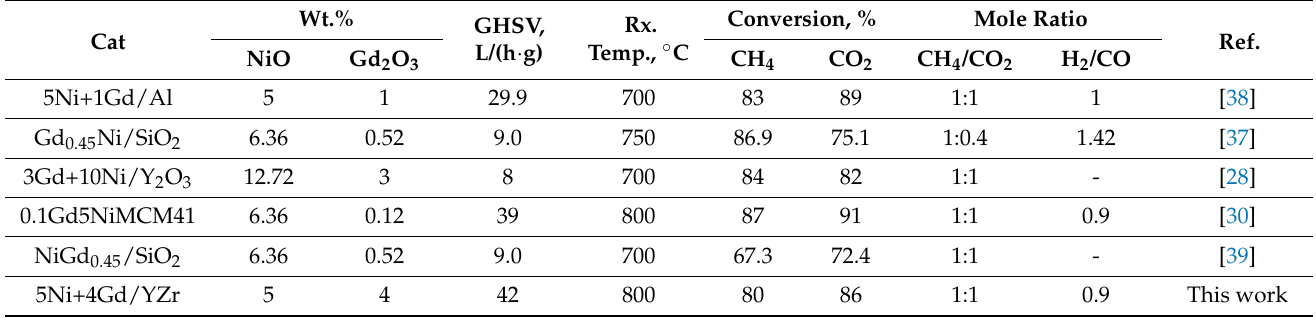
Figure 6. The conversions of ( A ) CH 4 , ( B ) CO 2 , and ( C ) H 2 /CO mole ratio at 800 ◦ C, one atmosphere, and GHSV = 42 L/h/g cat . Table 4. The comparison of our results with those reported previously in the